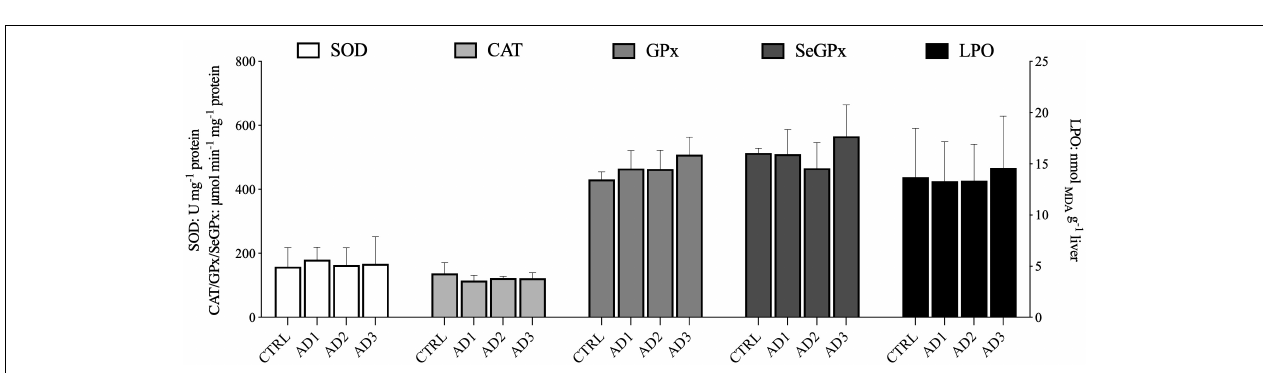
FIGURE 3 | Oxidative stress-related parameters in the liver of gilthead seabream fed the experimental diets over 12 weeks. No significant differences between dietary treatments were observed. Values are presented as mean ± SD.